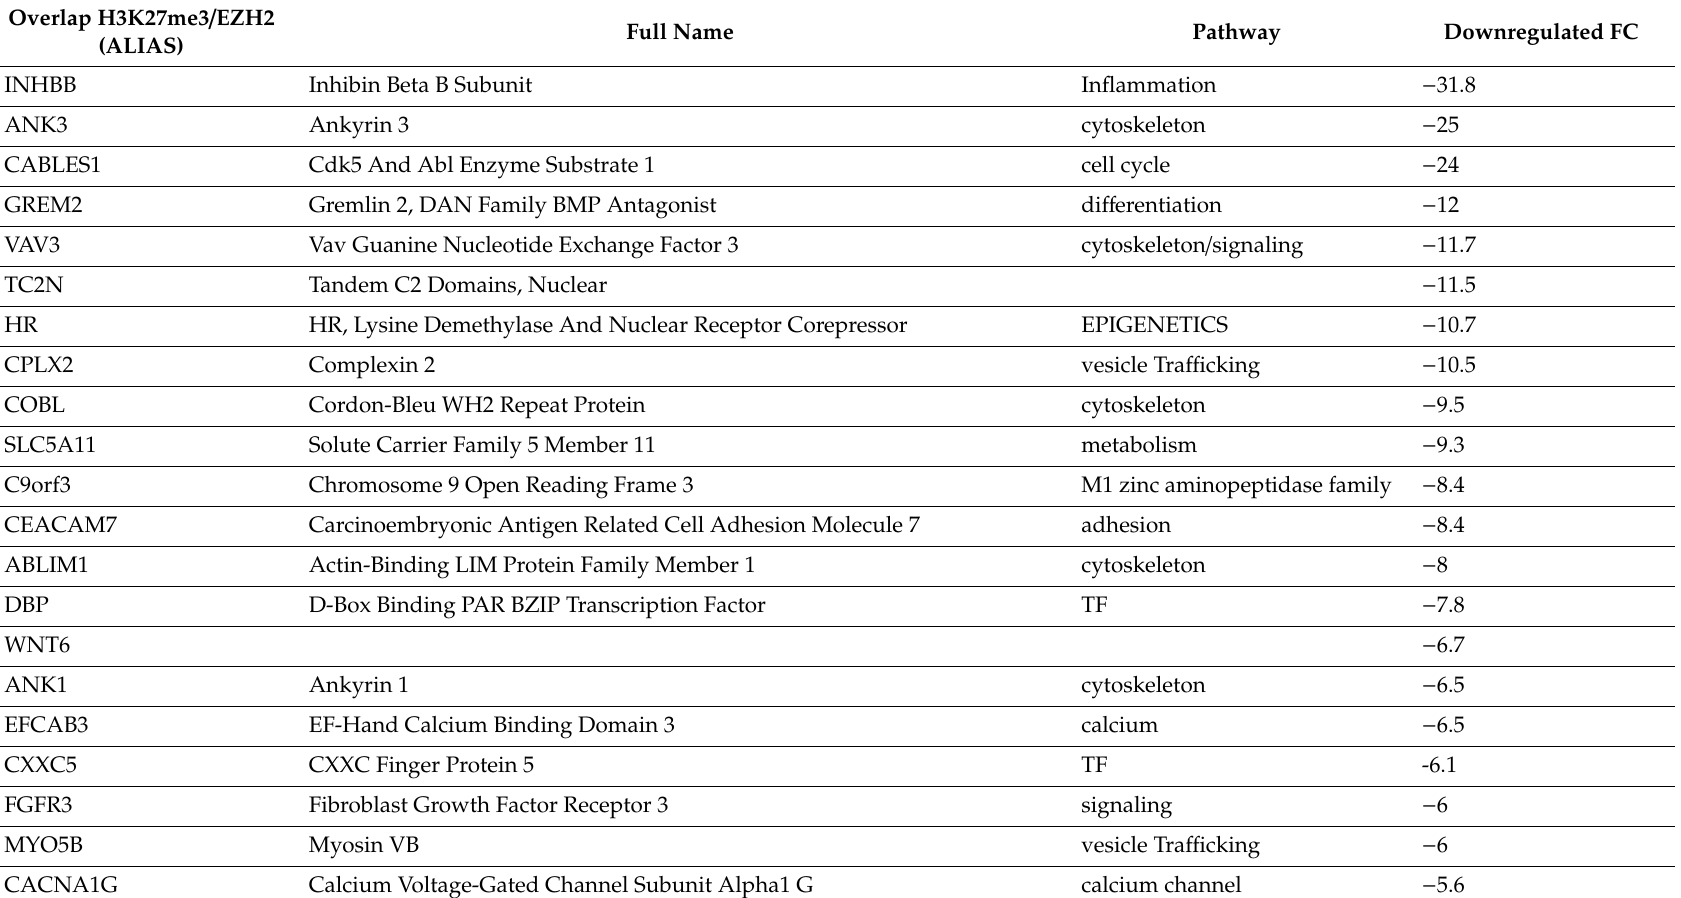
Table 1. A list of 40 most down-regulated genes in EMT associated with the H3K27me3 mark and EZH2 recruitment. Genes previously associated with EMT are